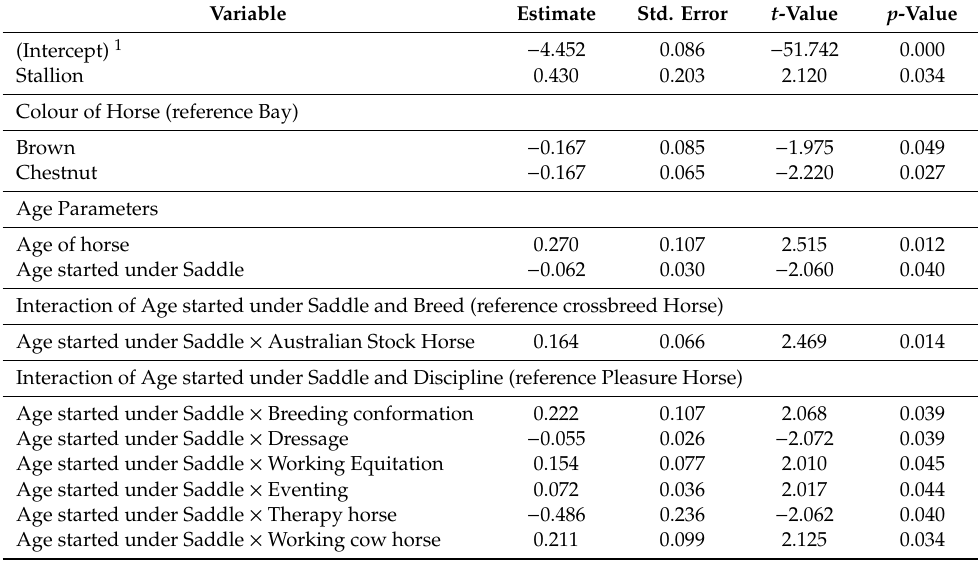
Table 4. Significant age-related variables for the suite of traits labelled Boldness for horses ( n = 1940) reported by respondents in the